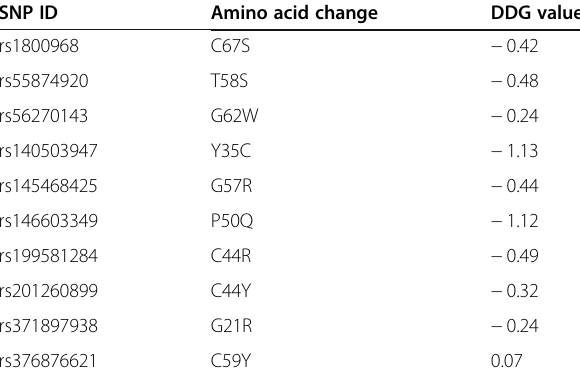
Table 2 DDG values as predicted by I-Mutant